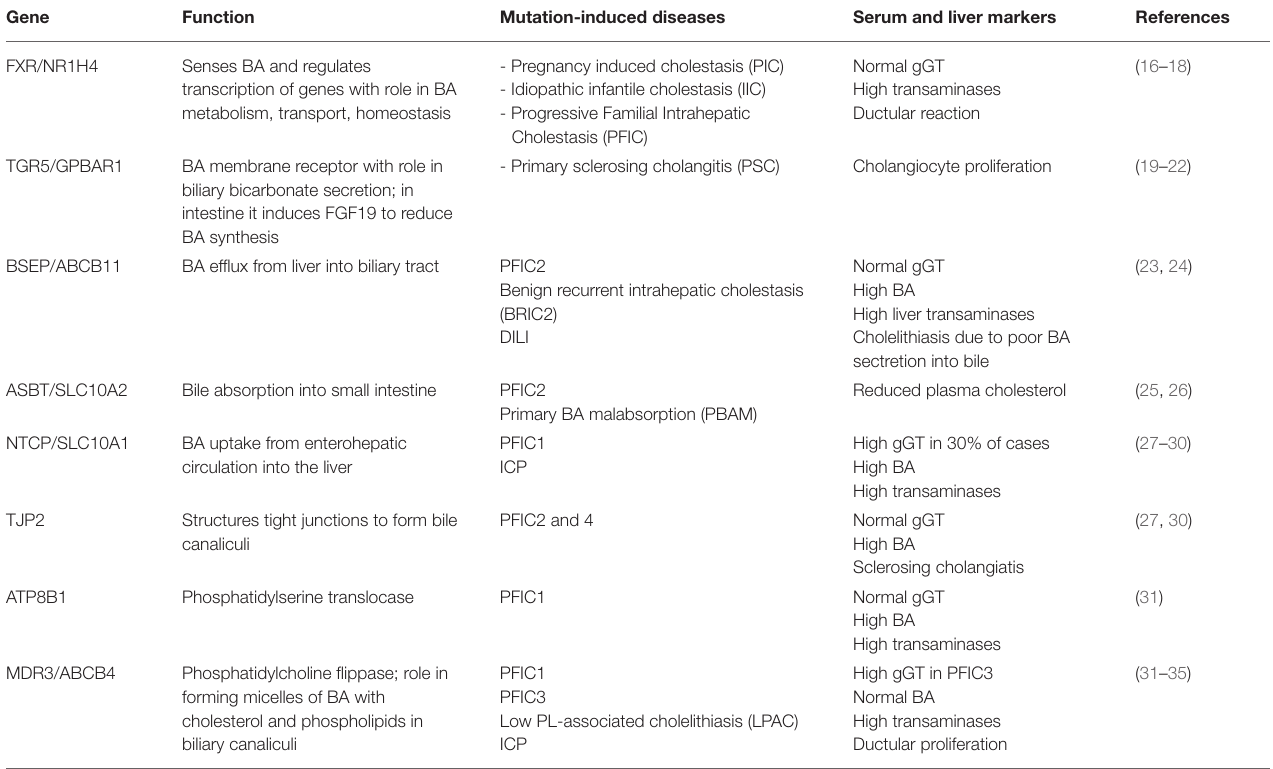
TABLE 1 | Genes associated with inborn hepatobiliary disorders and